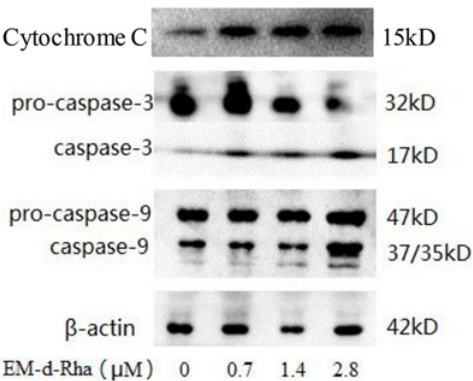
Fig 14. The effect of EM-d-Rha up-regulating the expression level of the proteins Cyto C, caspase-3 and caspase-9. Western blot analysis for Cyto C, Caspase-3 and Caspase-9 was performed with specific antibodies and β -actin as reference protein. The activation of caspase-3 and -9, which can be observed by the same molecular weight protein band 17kD and 37/35kD in Western blot.